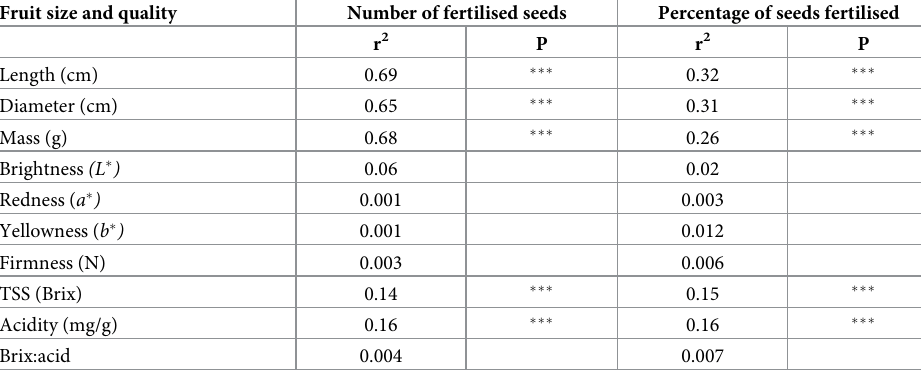
Table 6. Coefficients of determination for linear regressions between the number or percentage of fertilised seeds and fruit size and quality parameters of Sundrench strawberry fruit. Fruit size and quality Number of fertilised seeds Percentage of seeds fertilised